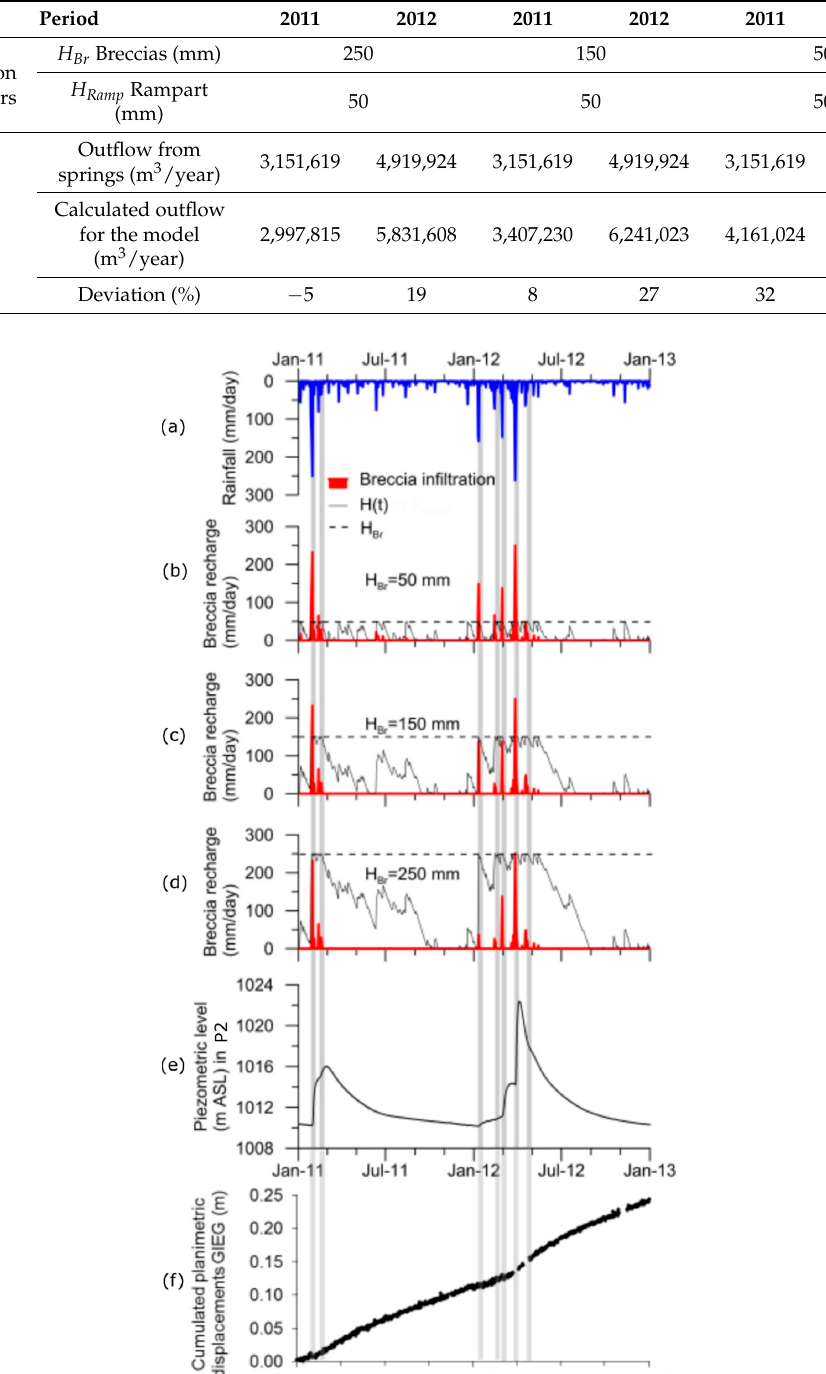
Table 4. Calibration and validation of the water budget based on estimated outflow. A sensitivity analysis was performed with an H Br value ranging from 250 mm to 50 mm for the landslide’s breccia. The best-balanced budget is obtained for a H Br value of 250